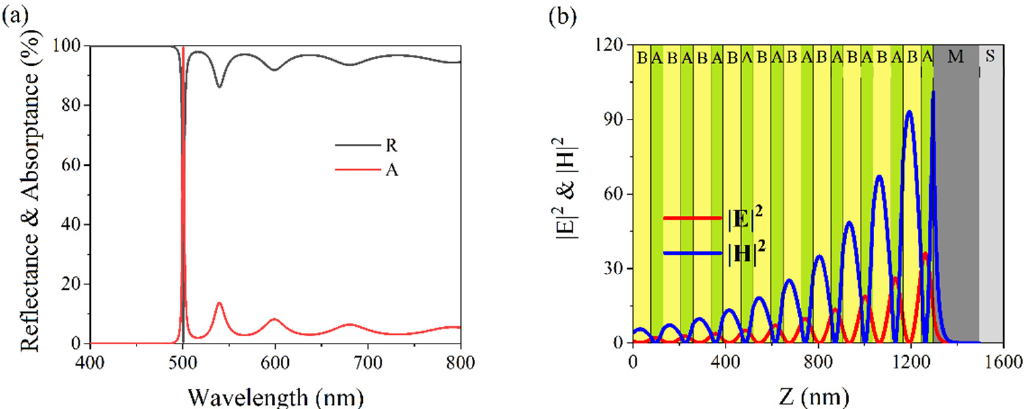
Figure 8. ( a ) Simulated reflection (solid black line) and absorption (solid red line) spectra of (BA) 10 MS. The parameters are d A = 77.4 nm, d B = 52.2 nm, and d M = 200 nm. ( b ) Simulated intensities of |E| 2 (solid red line) and |H| 2 (solid blue line) in (BA) 10 MS at an absorption wavelength of 500 nm.